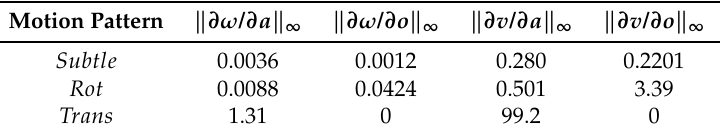
Table 1. ∞ -norm of submatrices under different motions.